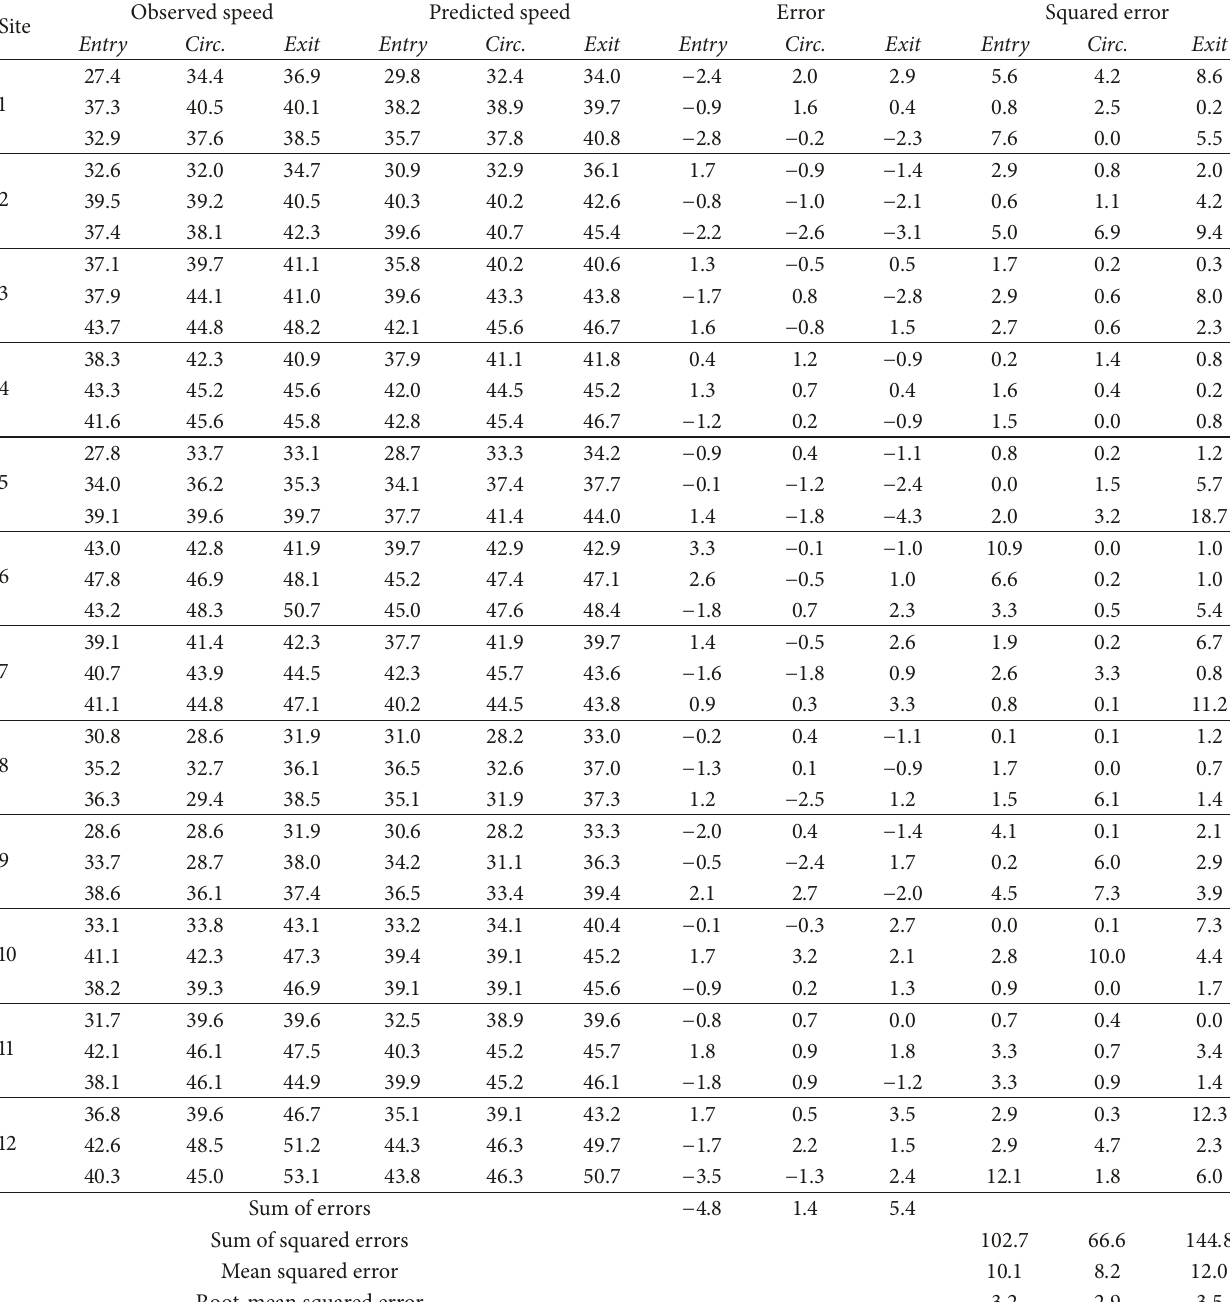
Table 4: Validation statistics of the speed prediction